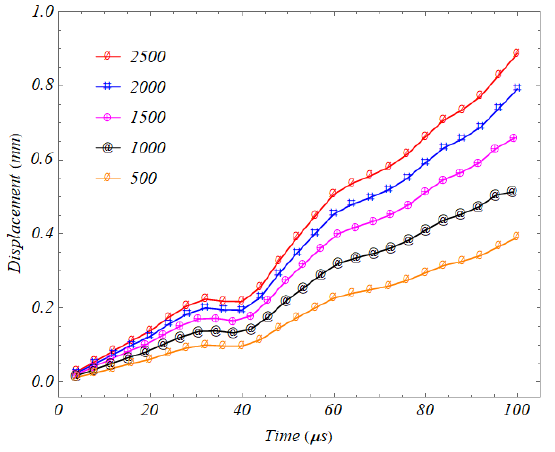
Fig. 30. Displacement against time for various drop distances with four cell phone casing laminates.